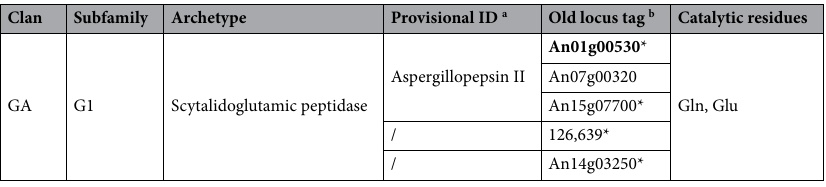
Table 3. Glutamic proteases encoded by A. niger strains CBS 513.88 and ATCC 1015. a /, not provisionally identified; b Proteases that have been molecularly and/or biochemically characterized are in bold; * Secreted proteases that have been predicted by the six